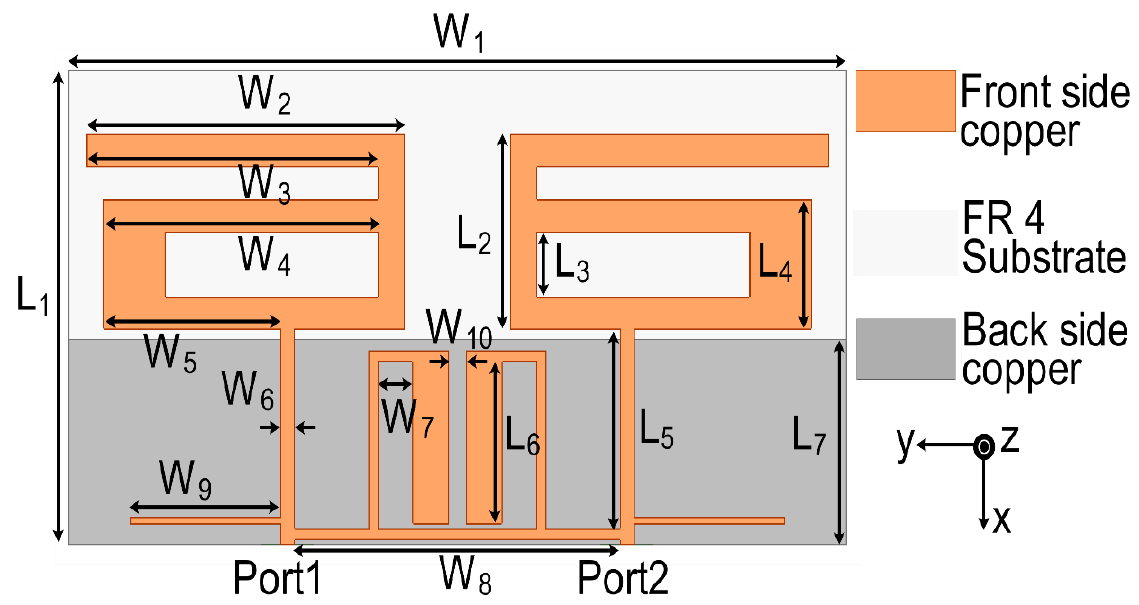
Figure 1. Final configuration of the two-port multiple-input multiple-output (MIMO)